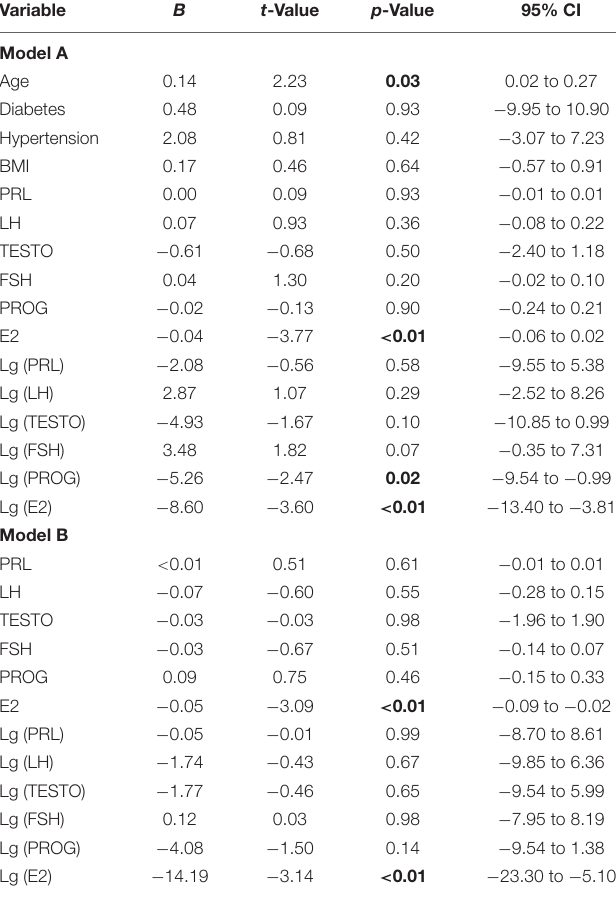
TABLE 3 | Univariate and multivariate logistic regression analyses to identify risk factors for women with POAG. Univariate